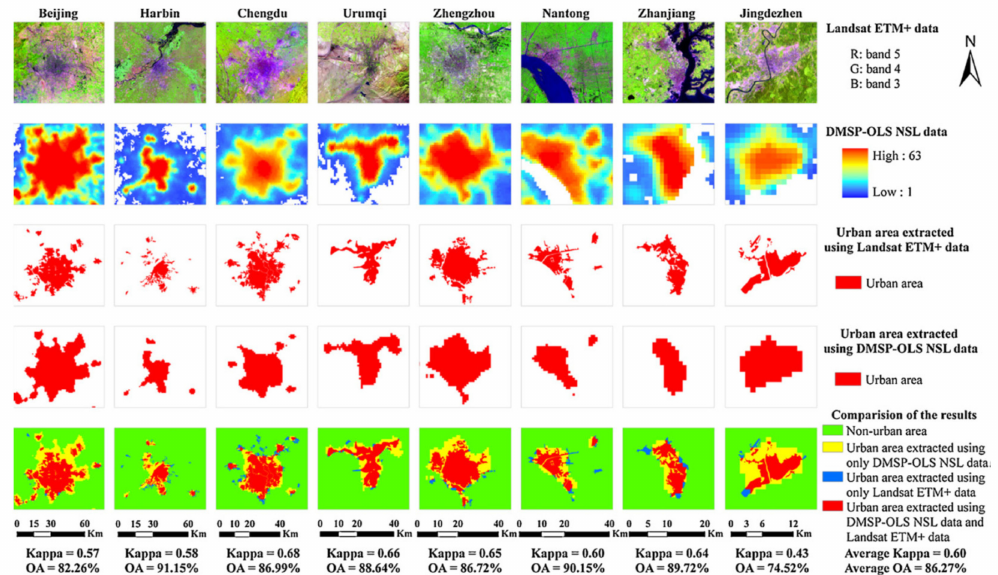
Figure 15. Accuracy assessment of selected urban areas in China in 2008 extracted using NSL data. Source: [91].